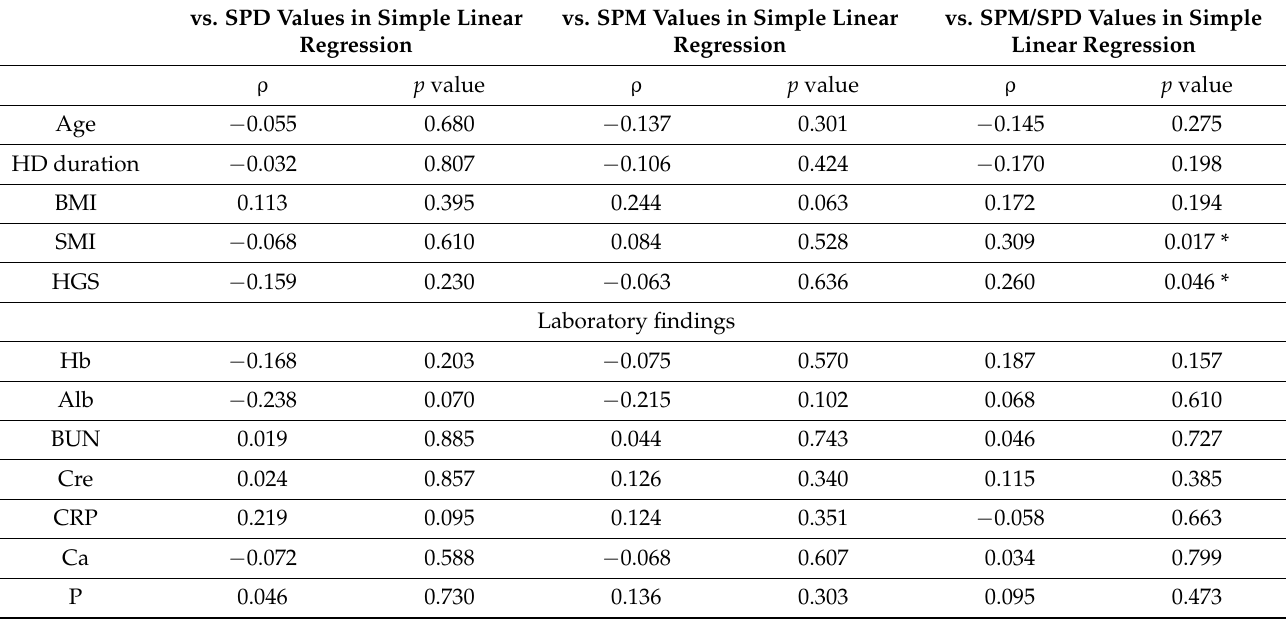
* Correlation is significant at the 0.05 level (two-tailed). As the values were not normally distributed, Spearman’s rank correlation was used to test correlations with polyamine concentration. HD,